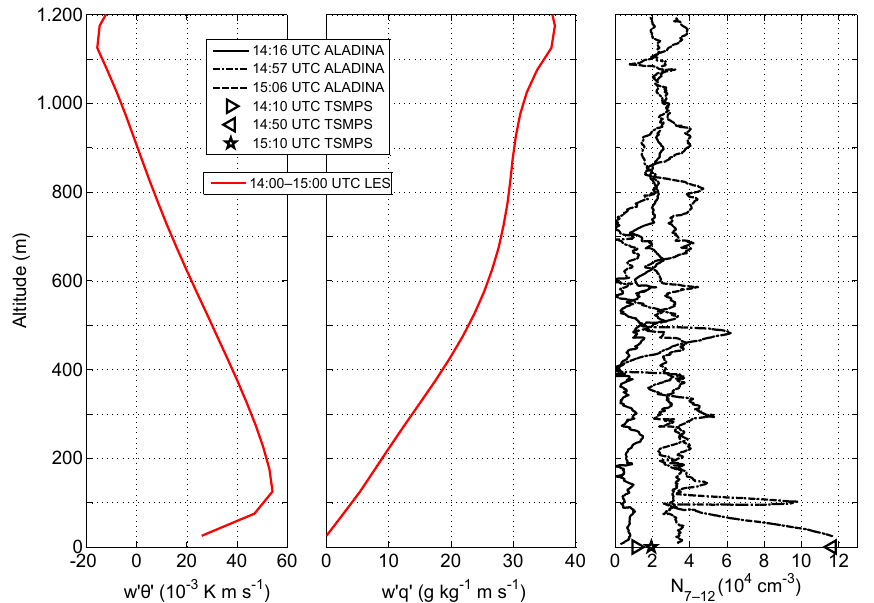
Figure 10. Vertical profiles of sensible heat flux w (cid:48) θ (cid:48) and latent heat flux w (cid:48) q (cid:48) obtained by LES output in the interval of 14:00–15:00UTC (red lines). Besides, three vertical profiles of freshly formed boundary aerosol in the particle diameter between 7 and 12nm ( N 7–12 ) measured with the CPCs on the UAS ALADINA at 14:16UTC (solid line), 14:57 (dotted line) and 15:06UTC (dashed line) are compared with the aerosol particle number concentration derived by TSMPS in the diameter range of 7 and 12nm at 14:10, 14:50 and 15:10UTC. All data were derived during the MelCol experiment on 21 June